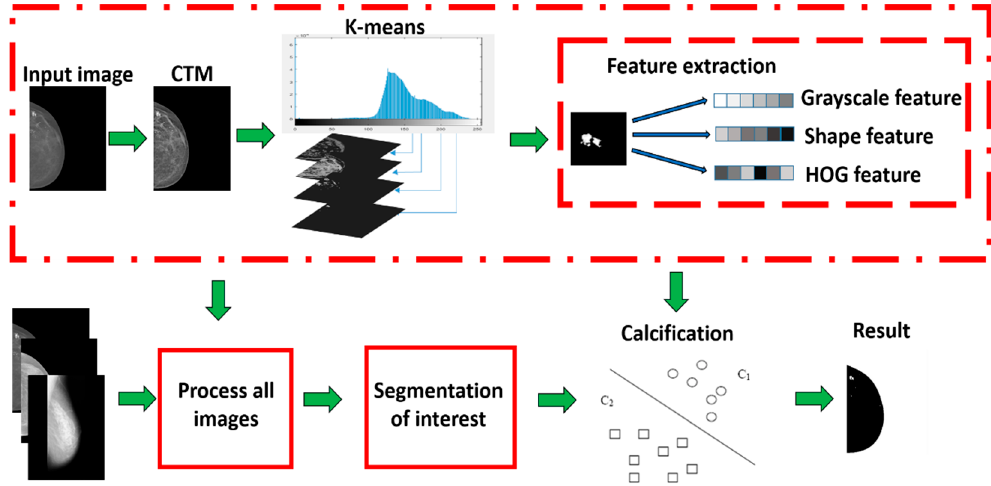
Figure 1. Flow chart of the computer-aided detection algorithm for breast calcification.